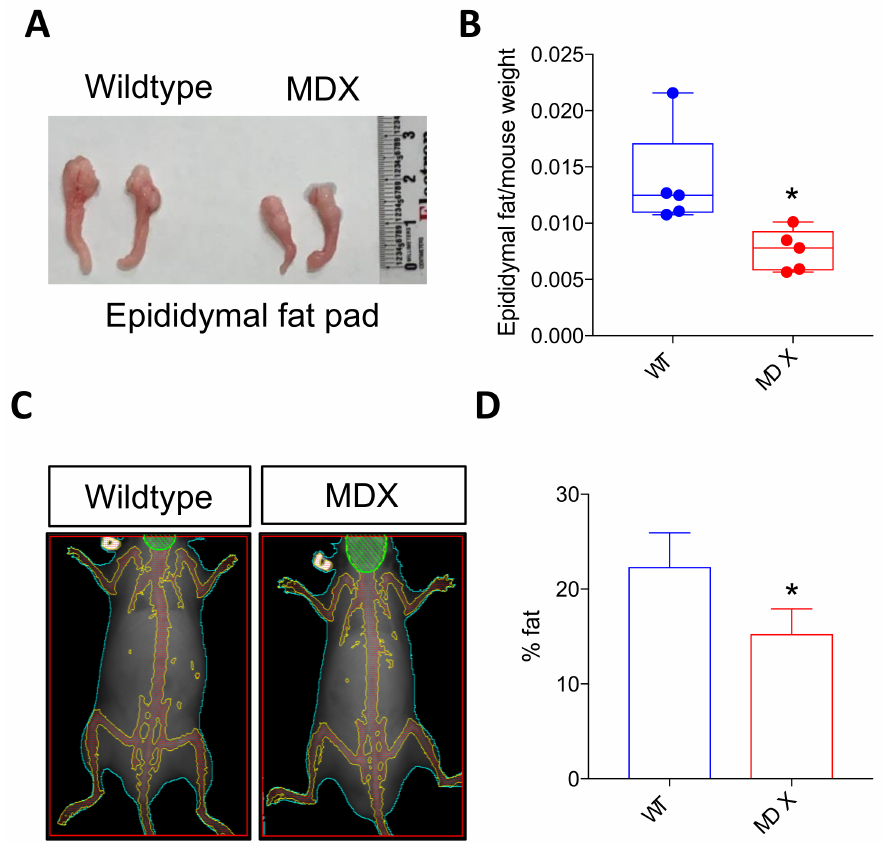
Figure 3. MDX mice exhibit decreased adipose tissue mass. ( A ) Images depicting WT and MDX epididymal fat pads. ( B ) A bar graph depicting epididymal fat pad weight normalized to total mouse weight. * p < 0.05. n = 5 mice in each experimental group. ( C ) Representative dual-energy X-ray absorptiometry (DEXA) images of WT and MDX mice. ( D ) Quantification of fat percentage based on DEXA image analysis. * p < 0.05. n = 4 mice in each experimental